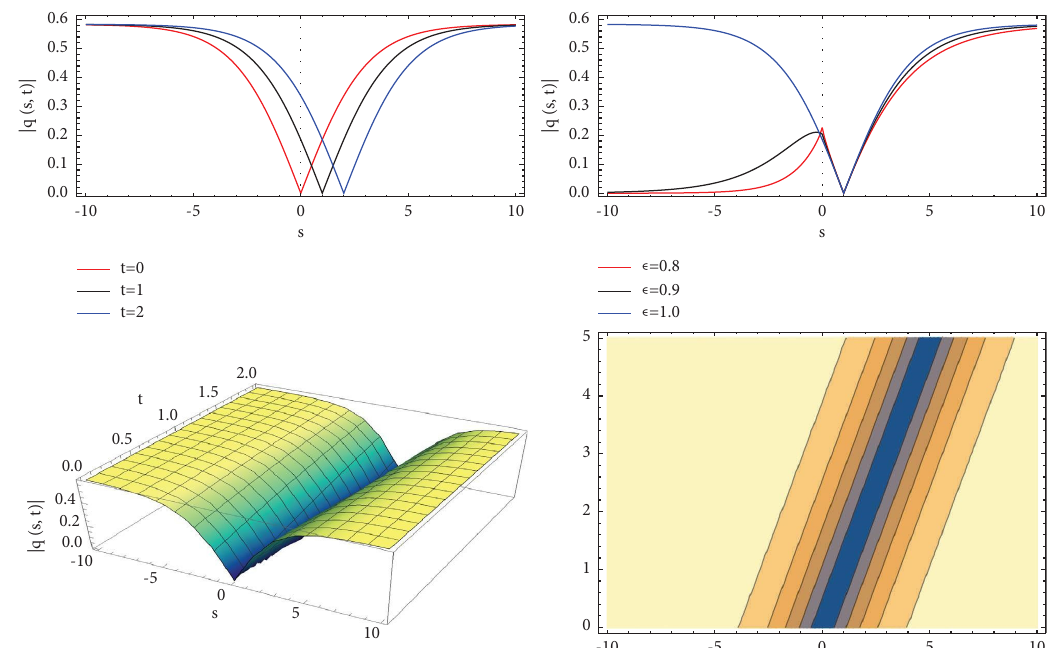
Figure 1: Structure of (34) for δ � 0 . 5 , λ � 0 . 3 , ϱ � 0 . 1 , μ � 2 , Ω � 0 . 7 , β